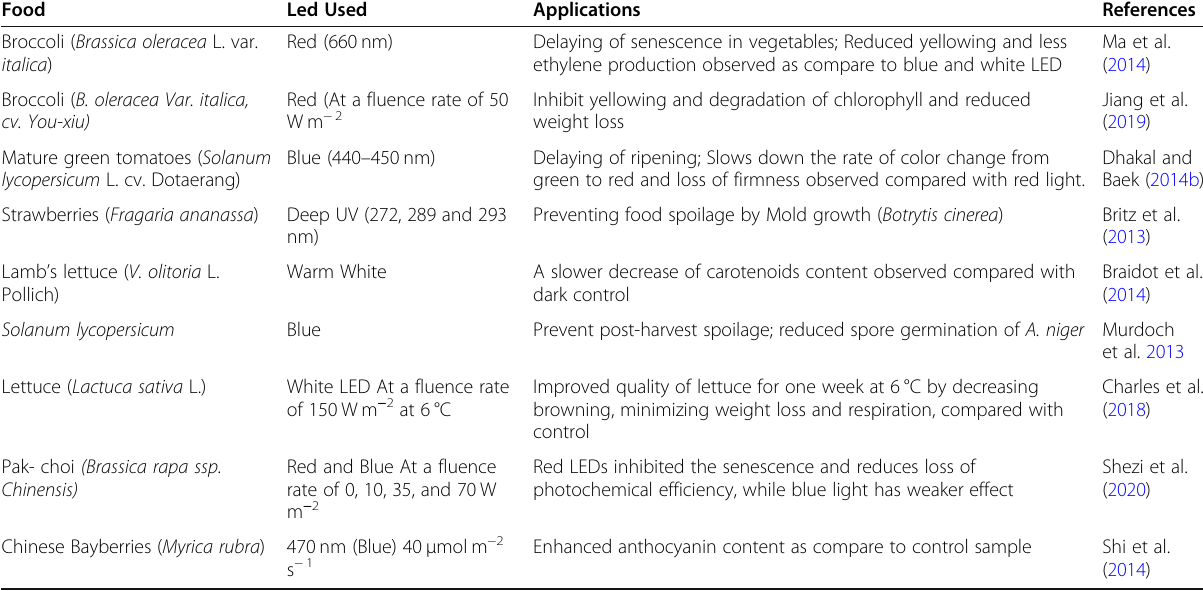
Table 1 Effect of LED treatment in prevention of post-harvest losses Food Led